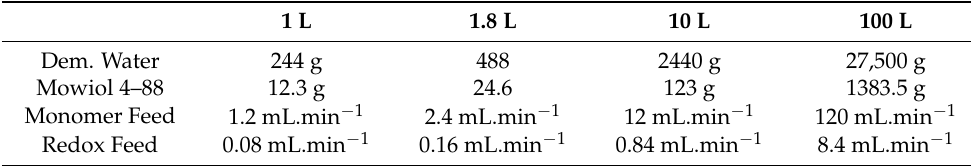
Table 4. Overview of the initial charge and feeding rates.